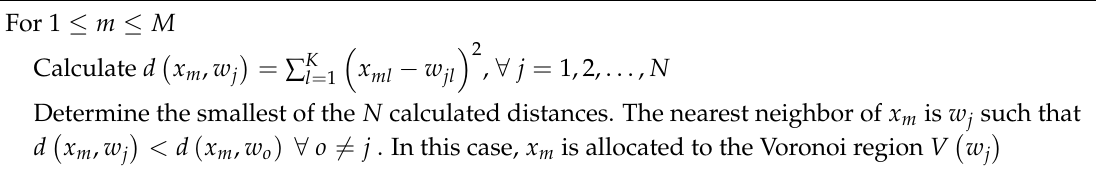
Algorithm 1. Partitioning step of the conventional FKM2 algorithm in crisp mode For 1 ≤ m ≤ M